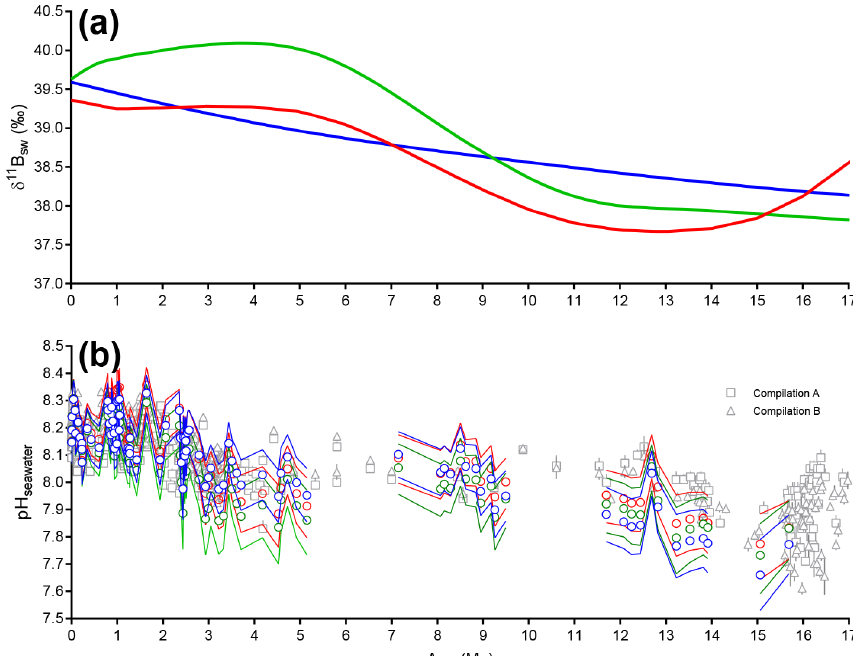
Figure 5. Different models for the evolution of the boron geochemistry explored as part of this work. Due to the 1‰ uncertainty propagated for δ 11 B seawater , all scenarios yield reconstructed seawater pH values that are within error of each other. Propagated uncertainties were calculated using Eq. (S14) (see Supplement). (a) Different models for δ 11 B seawater used for the reconstruction of p CO 2 in this study (blue – Lemarchand et al., 2002; green – Greenop et al., 2017; red – Raitzsch and Hönisch, 2013). (b) Reconstructed pH based on our measured δ 11 B carbonate values using different models for δ 11 B seawater (blue – Lemarchand et al., 2002; green – Greenop et al., 2017; red – Raitzsch and Hönisch, 2013), compilations of pH from Sosdian et al. (2018) (compilation A – open squares) and Rae et al. (2021) (compilation B – open triangles) are also shown for comparison. Data for compilation A are from Hönisch and Hemming (2009); Seki et al. (2010); Foster et al. (2012); Badger et al. (2013); Greenop et al. (2014); Martínez-Botí et al. (2015a); Chalk et al. (2017); Sosdian et al. (2018). Data for compilation B are from Foster (2008); Hönisch and Hemming (2009); Seki et al. (2010); Foster et al. (2012); Badger et al. (2013); Greenop et al. (2014); Martínez-Botí et al. (2015a); Chalk et al. (2017); Dyez et al. (2018); Sosdian et al. (2018); Greenop et al. (2019); de la Vega et al.